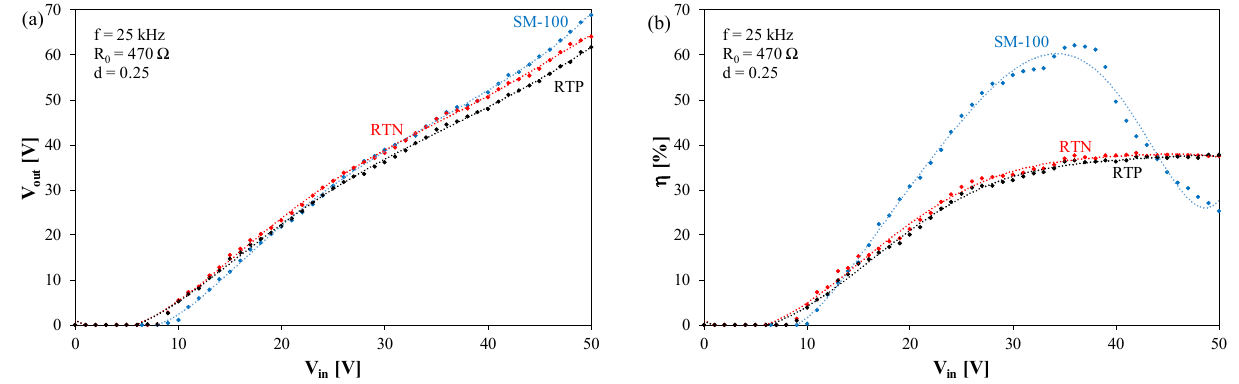
Figure 7. Measured dependences of the output voltage ( a ) and energy efficiency ( b ) of the tested DC-DC converter on its input voltage at R 0 = 470 Ω and d = 0.25.